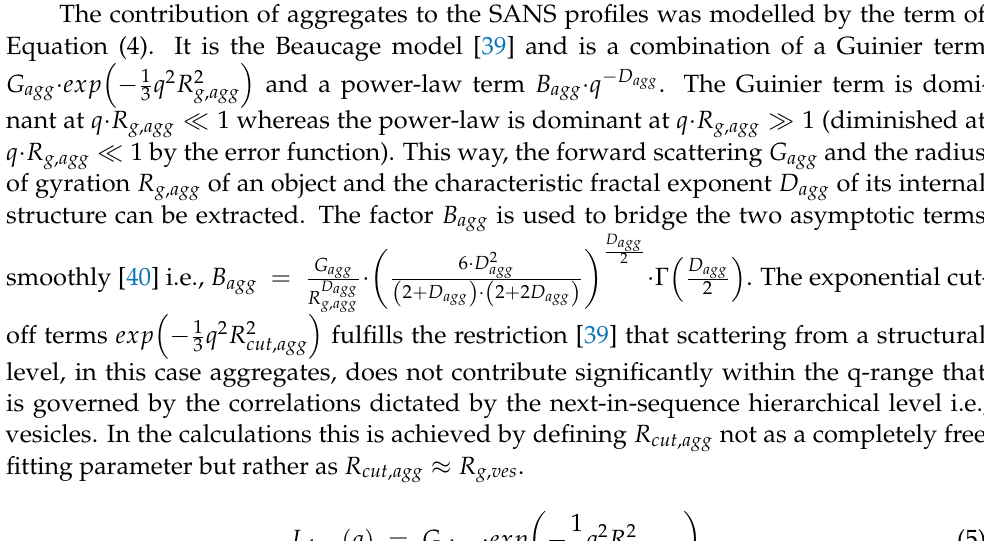
Scheme 1. Illustration of DPPC liposomes and main parameters for SANS